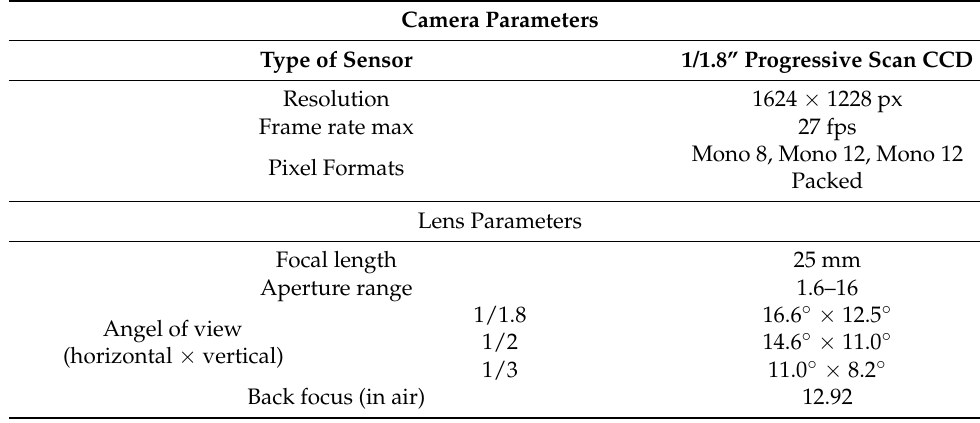
Figure 4. Schematic diagram of communication between the robots and the workstation. Table 1. KUKA MXG20 camera and Tamron M118FM25 lens